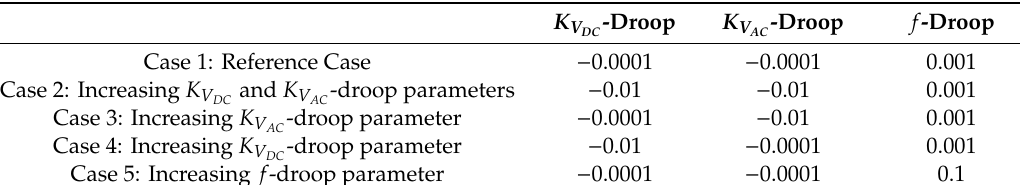
Table 1. Different droop parameters of VSC-HVDC station #4.